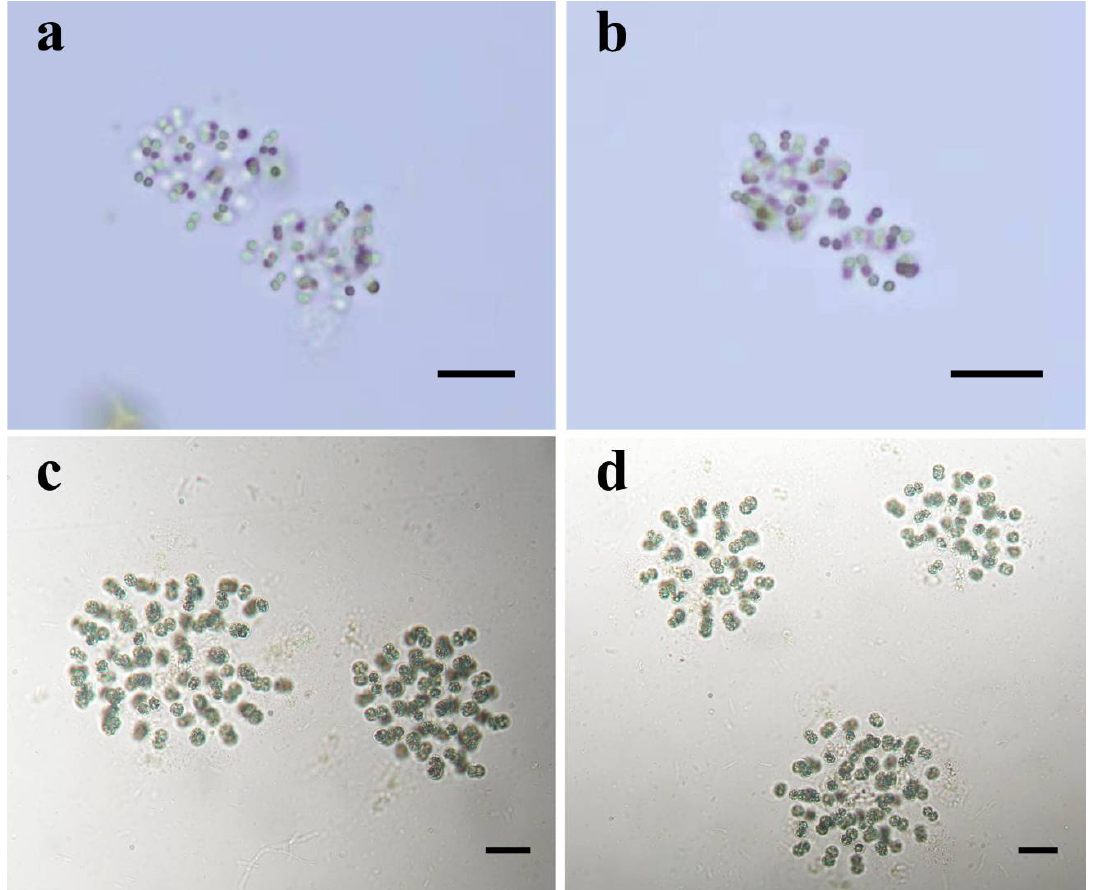
Figure 1. Images of Microcystis fernandoi under the light microscopy. ( a , b ): Microcystis fernandoi colonies from filed samples in Lake Erhai; ( c , d ): Microcystis fernandoi colonies from the strain WZU 1501 in liquid BG-11 medium. All scale bars are 20 μm.